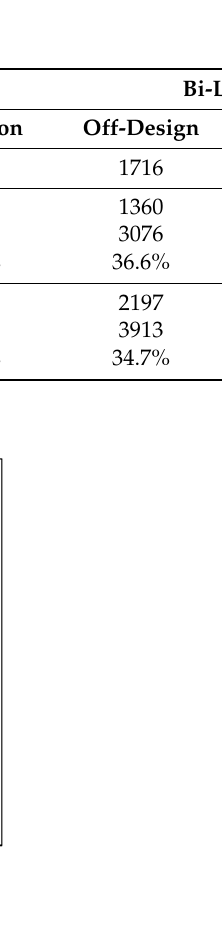
Figure 9. Mean temperature in the thermal storage